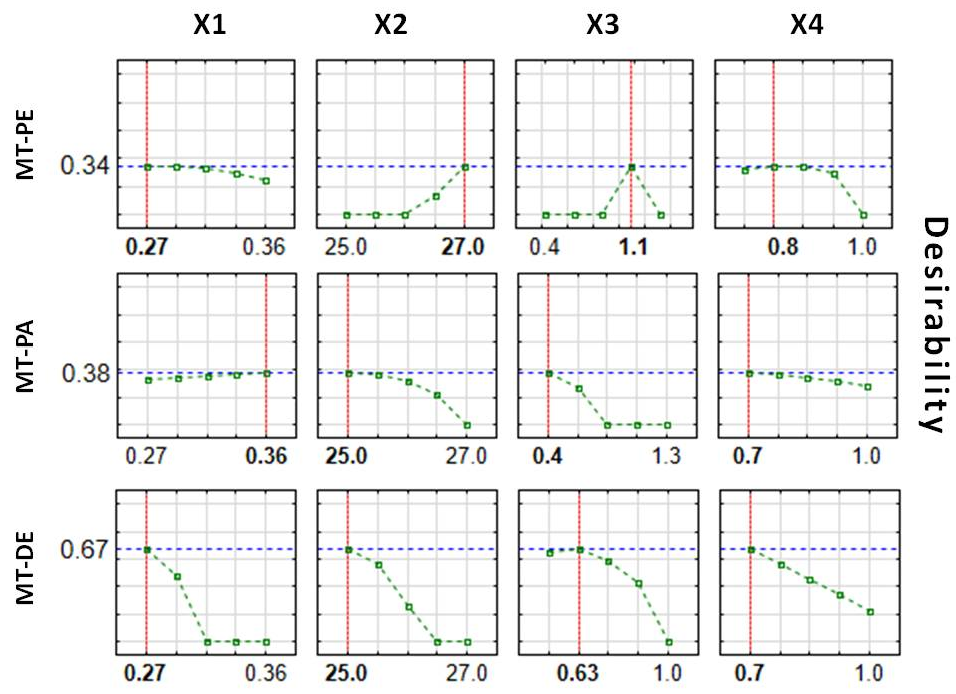
Figure 7. Predicted optimal values of factors X1–X4 and desirability of the fluid bed coating processes for all tested MTs.